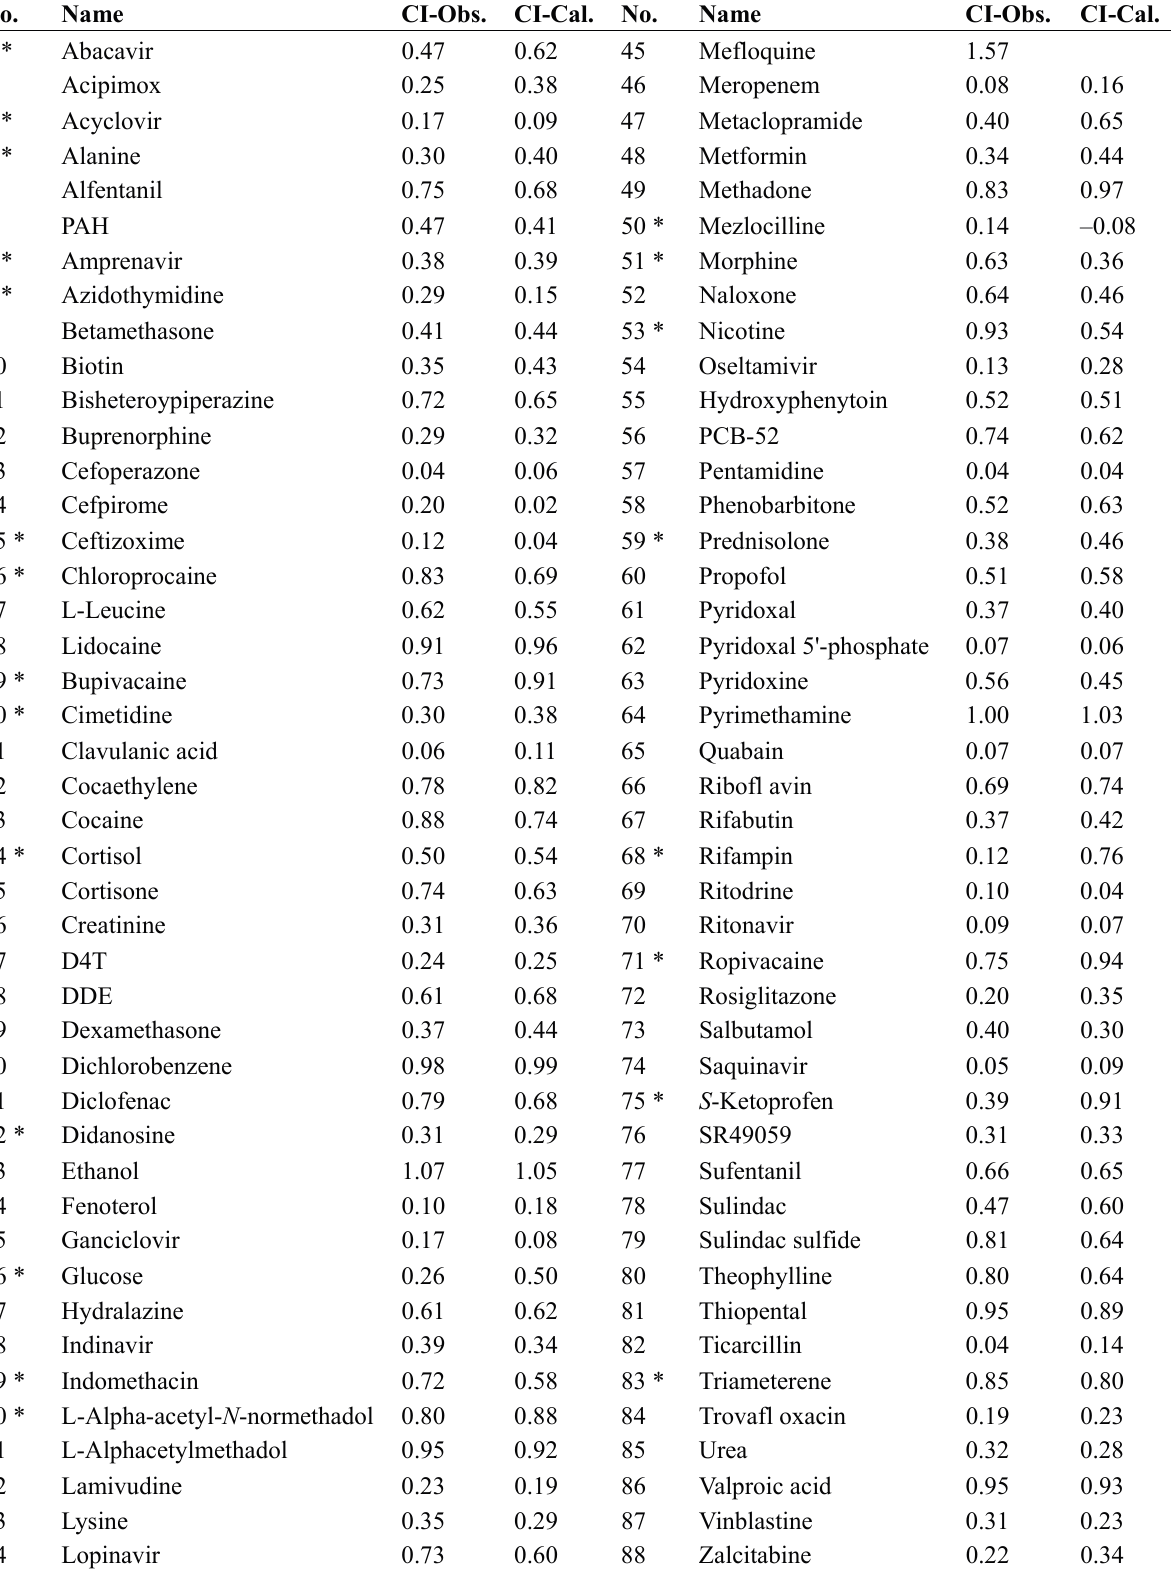
Table 3. Eighty-eight compounds and their CI observed and calculated values where the compounds with an asterisk (*) refer to ones in the test